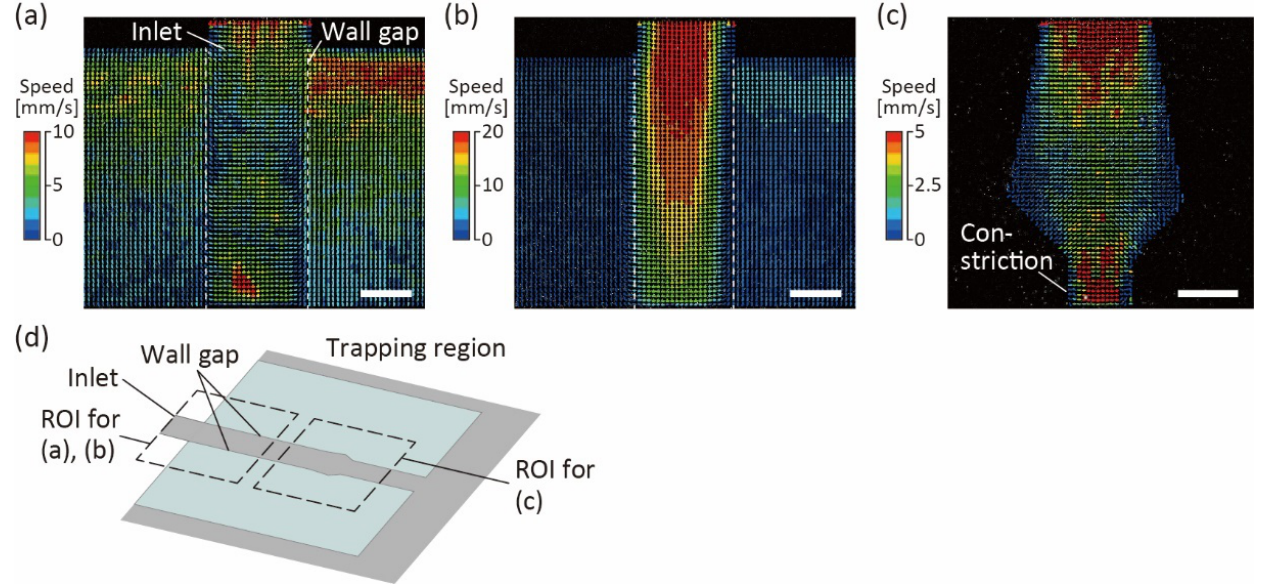
Figure 4. Bottom-view images with color vectors representing the speeds of fluorescent beads in the trapping region of the device. White dotted lines indicate the wall gaps in the channel. ( a ) Inlet of the trapping region near the bottom. ( b ) Inlet of the trapping region, at a height of more than 50 µm from the bottom. ( c ) Downstream of the trapping region near the bottom. ( d ) Schematic diagram for the trapping region, indicating the region of interest (ROI) for the vectors shown in ( a – c ). Scale bars are 100 µm.